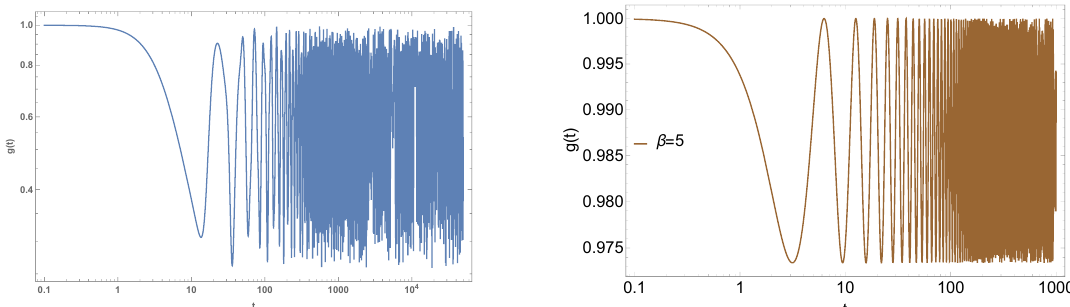
Figure 7. Left: SFF for BTZ black hole with z 0 = 2 , J cut = 80 , n = 1 and β = 5 . Right: SFF for empty AdS with dispersion relation ω β = 5 . These two figures show how the structure of SFF becomes empty AdS like when the cutoff is